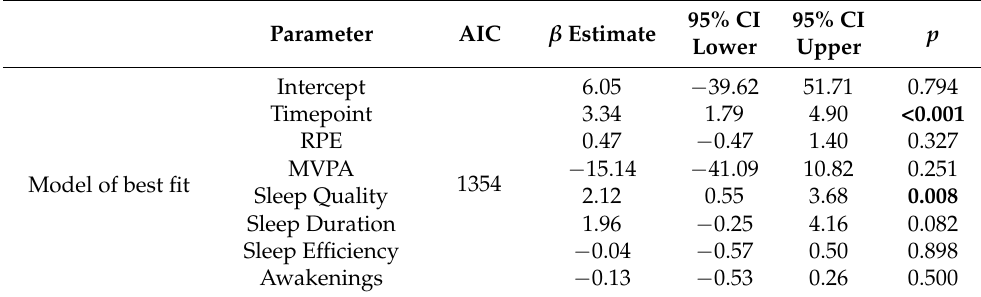
Table 3. Parameters of multi-level linear model of best fit for Multi-Component Training Distress Scale Total Score with combined workload and sleep